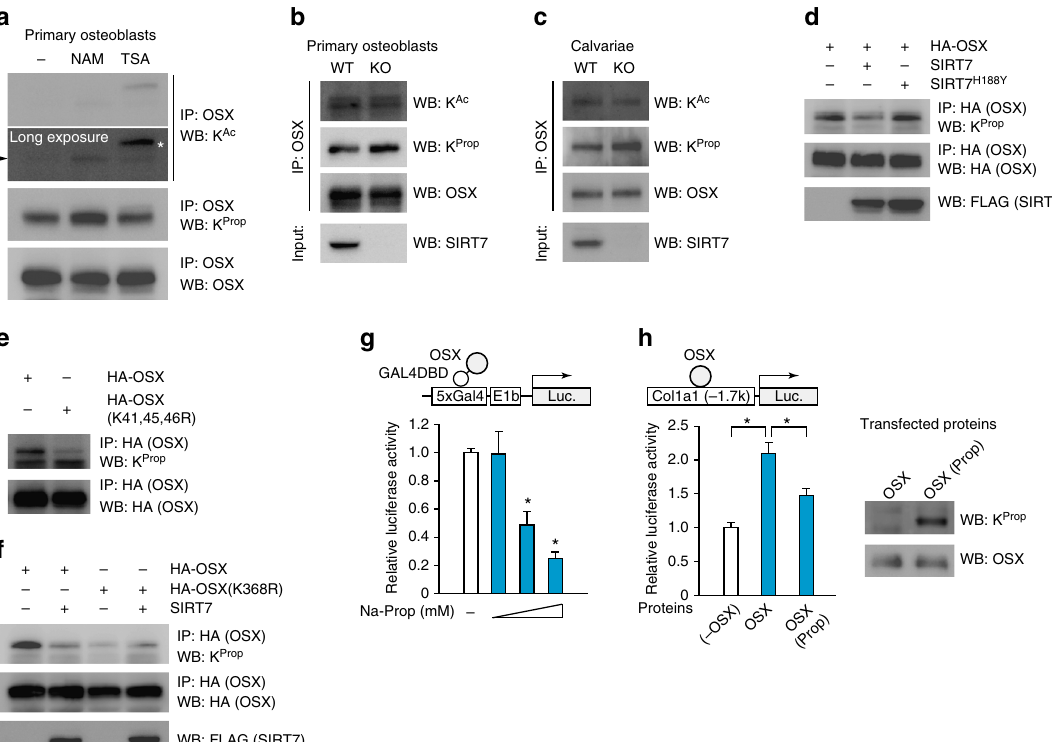
Fig. 7 SIRT7 regulate OSX lysine propioylation. a Detection of acetylated or propionylated OSX. Calvarial osteoblasts differentiated for 6 days were treated with 10 mM NAM for 24 h or with 1 μ M TSA for 6 h. After immunoprecipitation, acetylated and propionylated OSX were detected by WB. A long exposure time was required to detect acetylated OSX. Arrowhead and asterisk indicate OSX and non-speci fi c protein, respectively. b , c Effect of Sirt7 de fi ciency on acetylation and propionylation of OSX. Protein lysates of osteoblasts differentiated from bone marrow mesenchymal stem cells ( b ) or of calvariae ( c ) were subjected to immunoprecipitation, after which acetylated and propionylated OSX were detected by WB. d Effect of SIRT7 overexpression on propionylation of OSX. Sirt7 KO MEF were transfected with the 3× HA-OSX expression plasmid and the SIRT7 or SIRT7 H188Y expression plasmid, followed by treatment with 50 mM Na-Prop for 16 h. Propionylation of OSX was assessed by immunoprecipitation and WB. e , f Detection of propionylated OSX-mutants. MEF were transfected with the 3× HA-OSX or 3× HA-OSX (K41,45,46R) expression plasmid, after which cells were treated with 50 mM Na-Prop for 16 h ( e ). The 3× HA-OSX or 3× HA-OSX (K368R) expression plasmid combined with the SIRT7 or empty expression plasmid were transfected into Sirt7 KO MEF, which were subsequently treated with 50 mM Na-Prop for 16 h ( f ). Propionylation of OSX was assessed by immunoprecipitation and WB. g Impact of propionylation on transactivation activity of OSX. MC3T3-E1 cells were transfected with the GAL4DBD-OSX expression plasmid, and then were treated with 10, 30, 50 mM Na-Prop for 24 h. Subsequently, cells were transfected with the 5× GAL4-luciferase reporter and the reporter assay was performed after 24 h ( n = 5 each). h Luciferase assay using recombinant OSX protein. OSX protein was transfected into MC3T3-E1 cells, followed by transfection of the Col1a1 enhancer/promoter-driven luciferase reporter after 2 h. The reporter assay was performed at 18 h after luciferase transfection (left) ( n = 4 each). Transfected proteins were con fi rmed by WB (right). WB, western blotting; IP, immunoprecipitation; K Ac acetyl lysine, K Prop propionyl lysine. Data are shown as the mean ± SEM. Statistical signi fi cance was determined by Student ’ s t -test. * p < 0.05 vs. 0 mM Na-Prop ( g